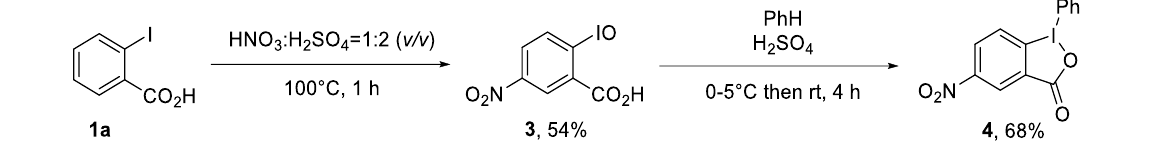
Scheme 2. Preparation of 5-nitro-1-phenyl-1 λ 3 -benzo[ d ] [1,2]iodaoxol-3(1 H )-one 4 .